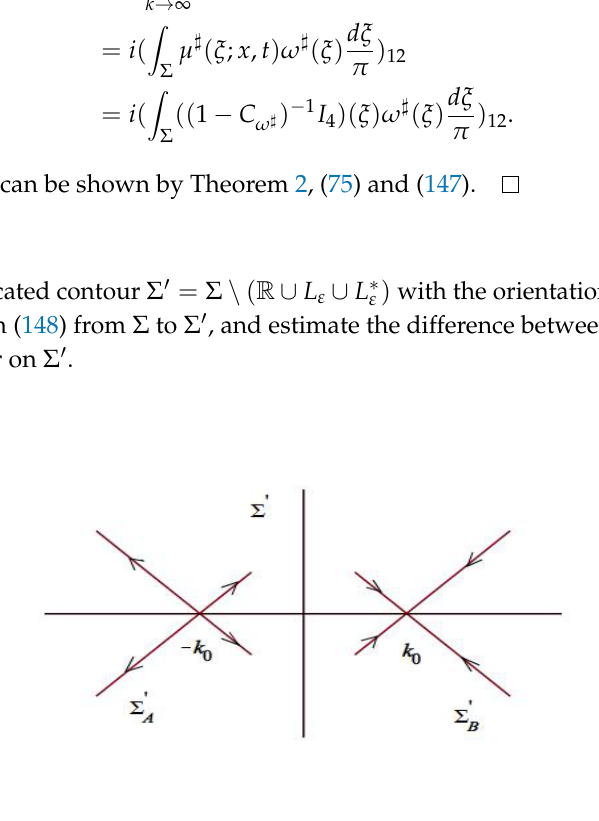
Figure 8. The oriented contour Σ (cid:48) = Σ (cid:48)